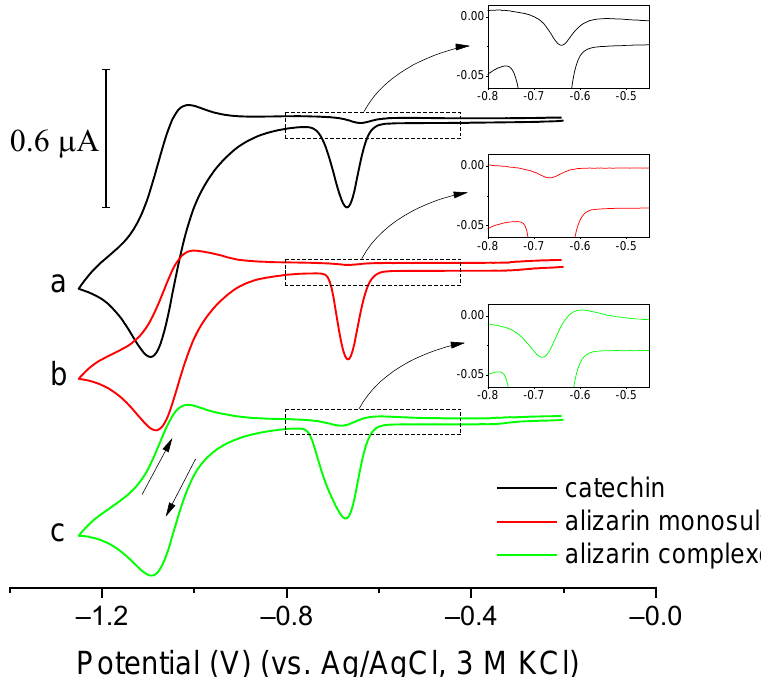
Figure 14. Cyclic voltammograms recorded in 0.1 M acetate buffer containing: (a) 5 µM of catechin, (b) 5 µ M of alizarin sodium monosulfonate or 5 µ M of alizarin complexone (c) and 50 µ M of Ge(IV), (b) 5 µM of alizarin sodium monosulfonate or 5 µM of alizarin complexone (c) and 50 µM of Ge(IV), 0.8 mM of V(IV), 1.6 mM of HEDTA. Scan rate 50 mVs − 1 . The HMDE electrode served as the 0.8 mM of V(IV), 1.6 mM of HEDTA. Scan rate 50 mVs −1 . The HMDE electrode served as the working working electrode.